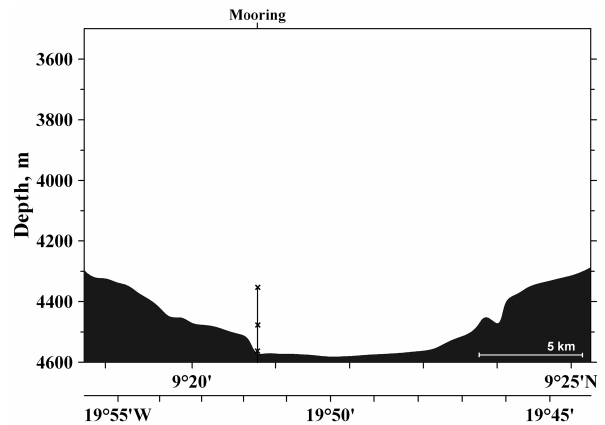
Fig. 4. A scheme of the mooring location over the topographic sec- tion across the Kane Gap. Crosses indicate the depths of current meters. The horizontal scale is shown in the bottom right